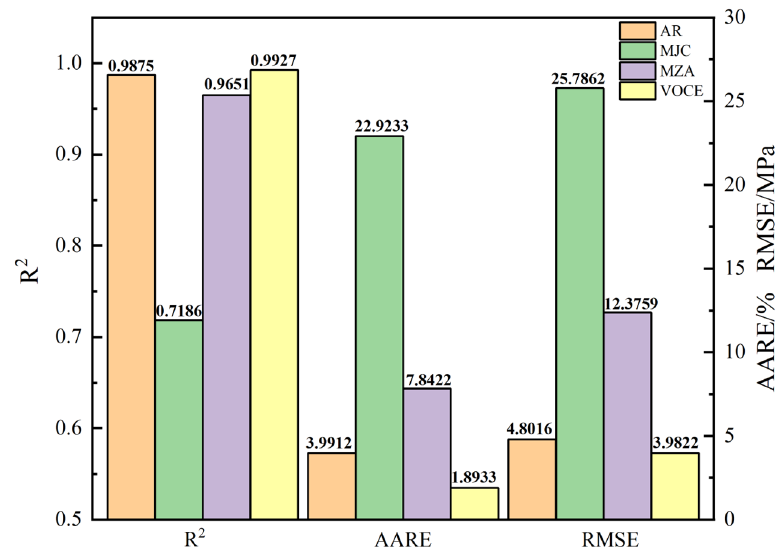
Figure 16. Comparison of R 2 , AARE, and RMSE for stress values predicted by different models.